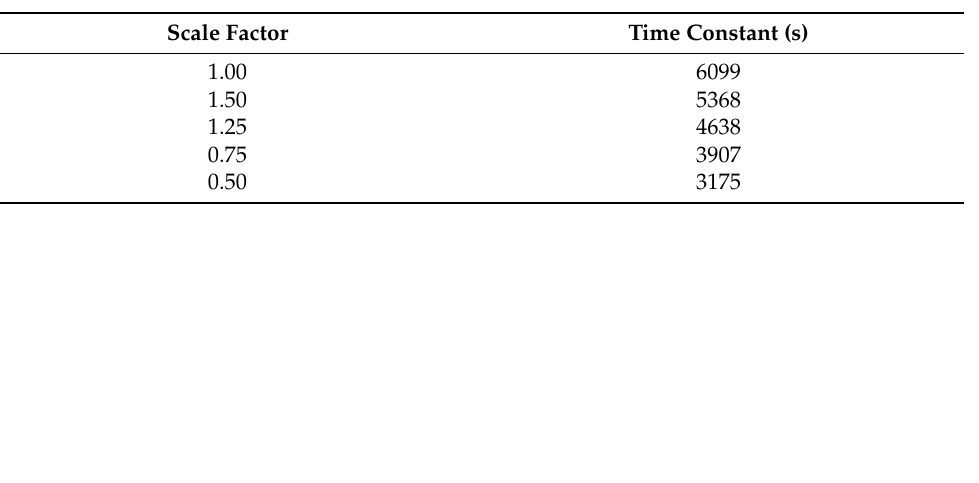
Table 9. Bioreactor tank time constants based on the scale factors of the feed-mixing